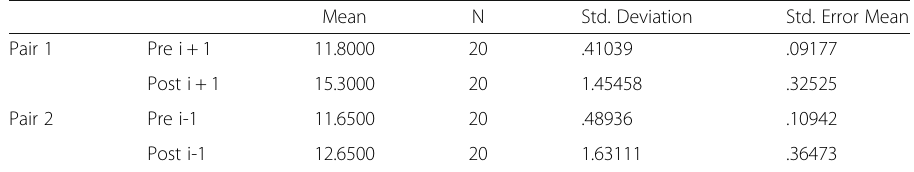
Table 4 Paired Samples Statistics (Pre and Post-tests of Both